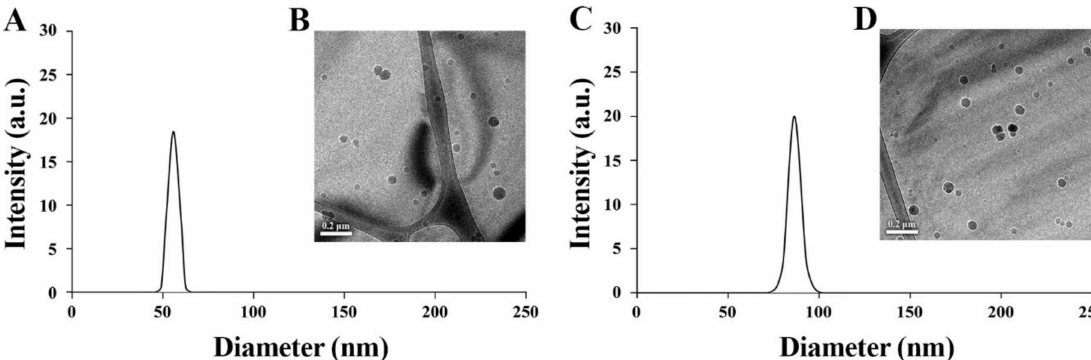
Figure 3. Hydrodynamicsizehistogramsobtainedbydynamiclightscatteringandcryogenictransmission electron microscope images of P(EFH-PLLA) ( A , B ) and P(EFH-PLLA) / RSP ( C , D